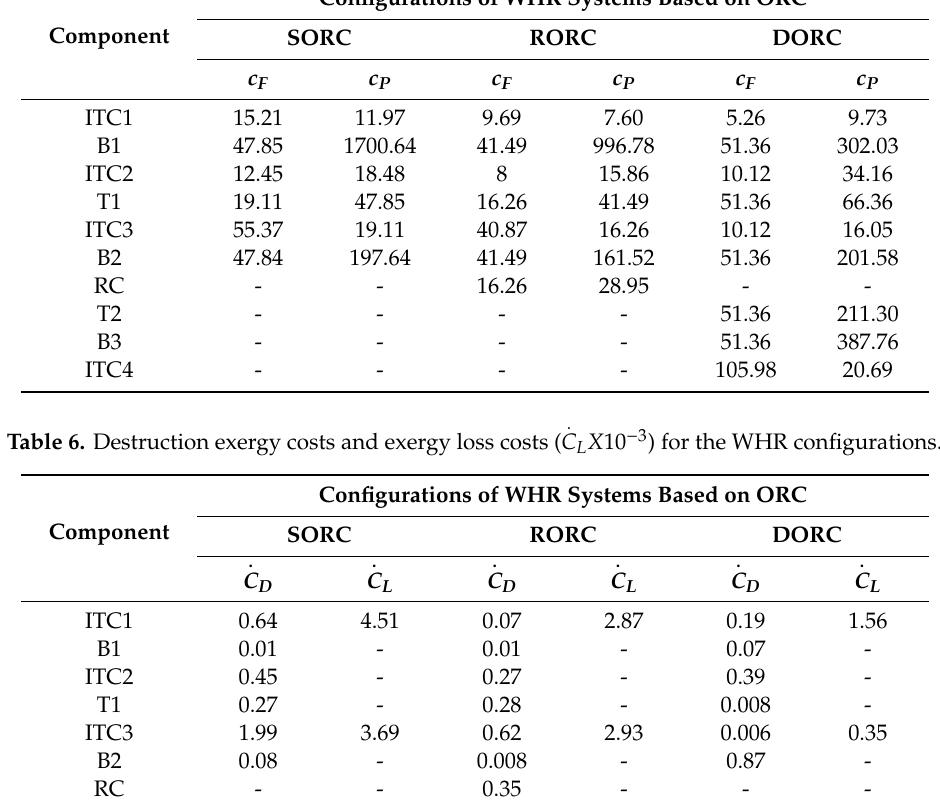
Table 5. Fuel and product costs (USD / GJ) for each component. Configurations of WHR Systems Based on ORC Component SORC